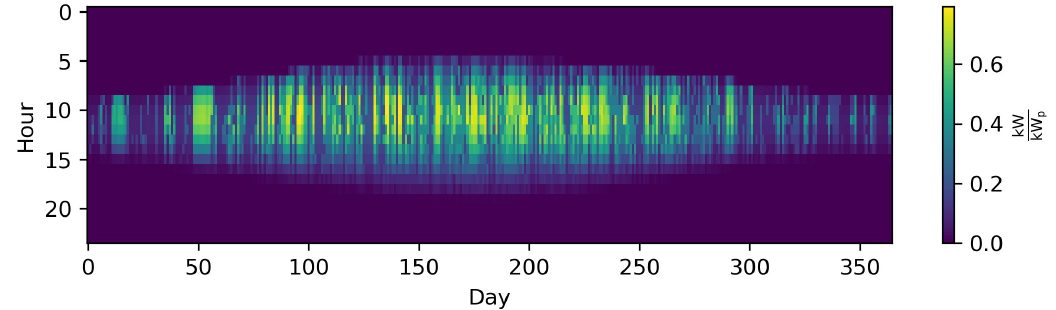
Figure 3. One year of hourly resolved photovoltaic capacity factors simulated with PV-Lib [60].